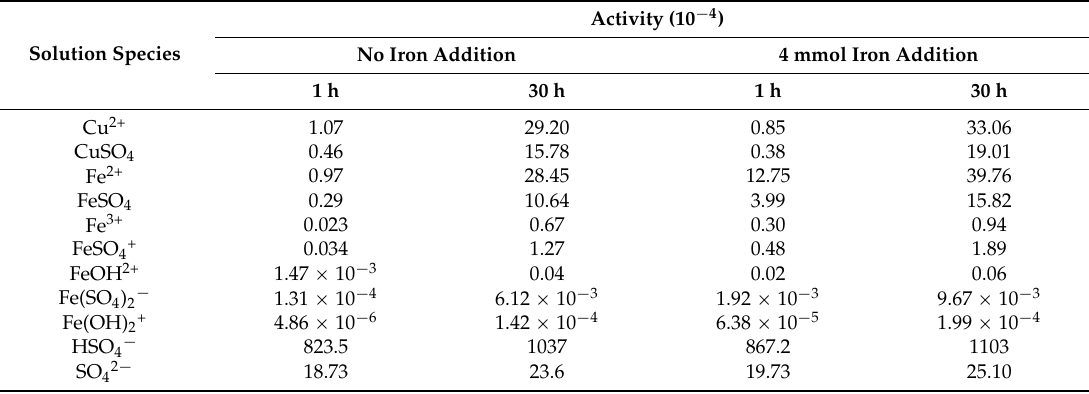
Table 2. The activities of predominant Fe, Cu and S species calculated for 1 h and 30 h of leaching